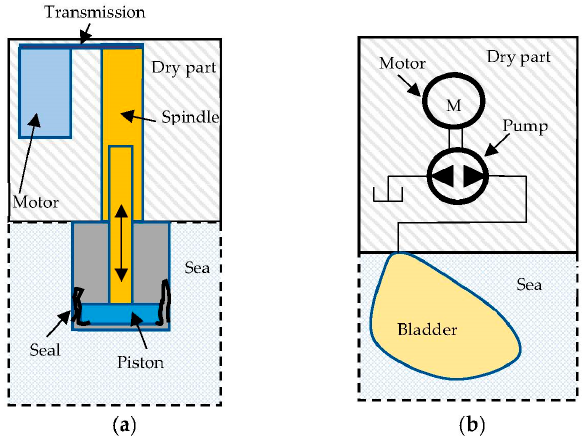
Figure 1. Schematics of ( a ) electromechanical and ( b ) electrohydraulic BCD working principle.